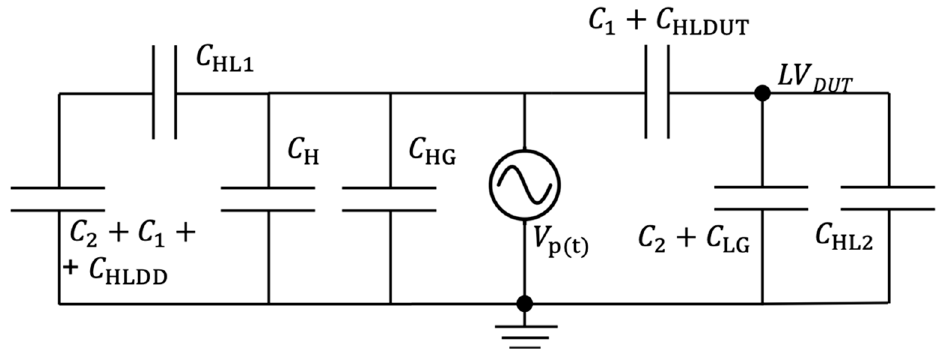
Figure 4. Equivalent circuit of the test condition T1.